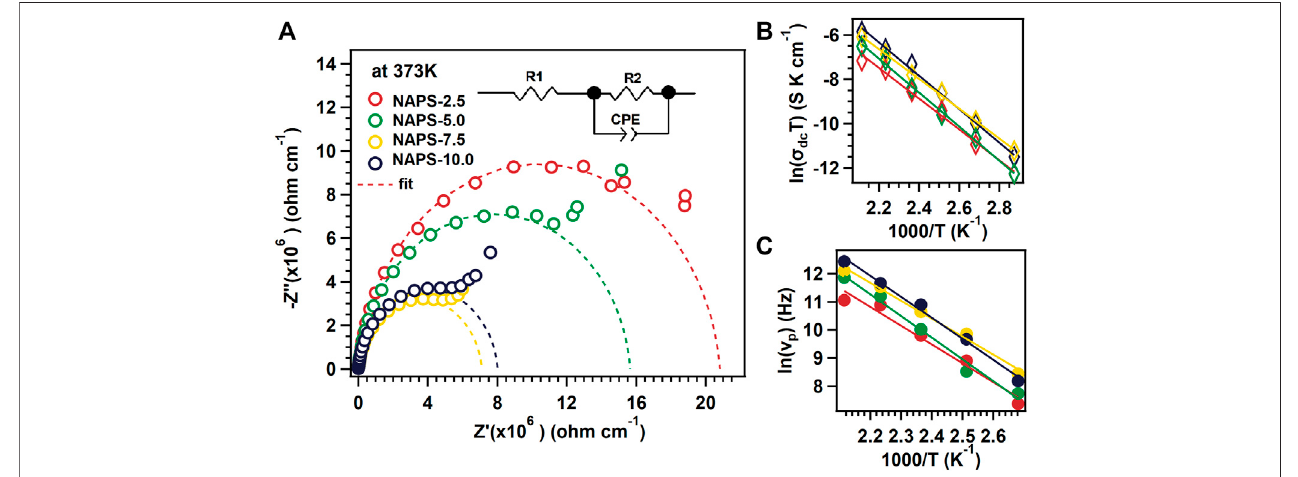
FIGURE 5 | (A) Impedance spectra for different glass samples at 373 K temperate. Inset shows equivalent circuit for dashed fi tted lines. (B) Arrhenius plot for different temperature and glass samples. (C) Temperature dependence of ν P for different glass